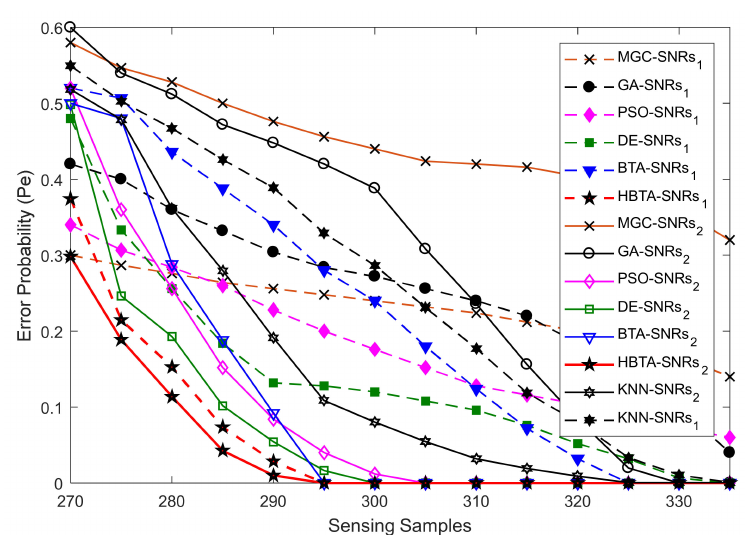
Figure 12. Error probability vs. sensing samples in the presence of AO-AOC users with SNRs 1 ( − 9.5 dB) and SNRs 2 ( − 0.5